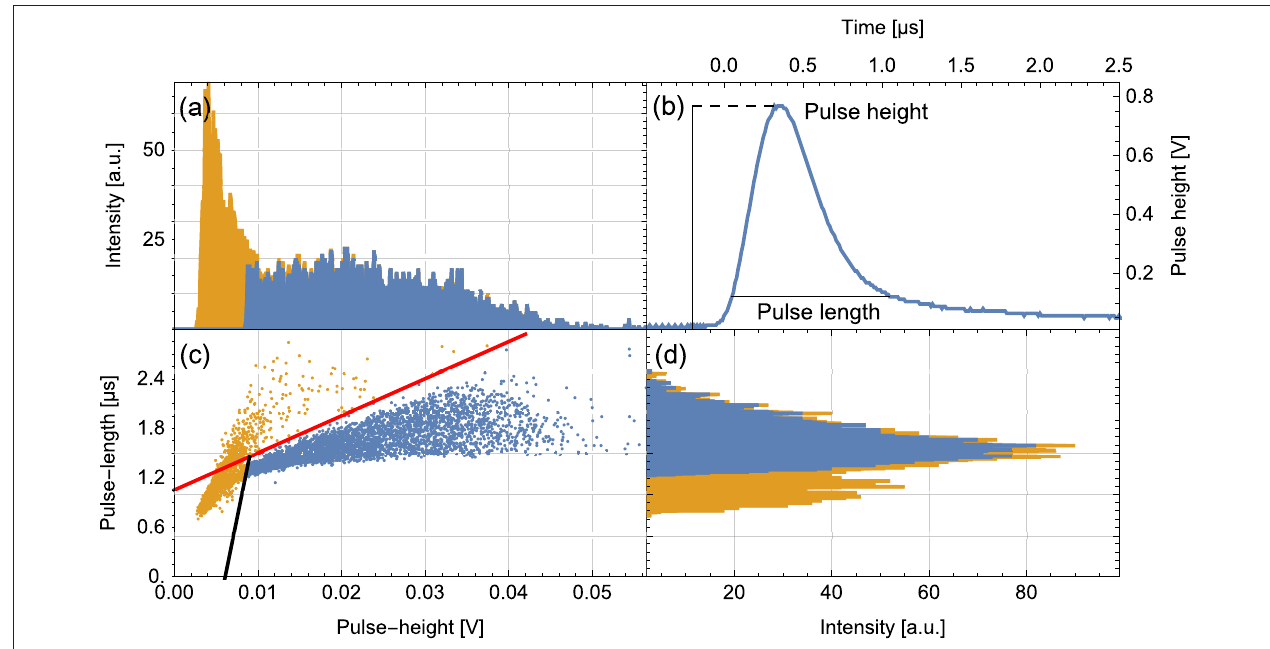
FIGURE 8 | Pulse shape analysis for a boron-lined detector at a counting gas pressure of 1bar. (a) Shows the pulse height spectrum of 6,200 detected events. (b) Displays a pulse generated by the readout electronics corresponding to a neutron event and indicates how pulse height and length are determined. Pulse length corresponds to the time interval during which the pulse exceeds a certain threshold voltage level. The scatter plot (c) depicts the two-dimensional pulse data of the detected events. (d) Shows the event pulse length data as a histogram. (a,d) Are the projections of (c) to the pulse height and length axis, respectively. The blue events could be identified as neutrons whereas the orange cluster contains both electrons and neutrons. These regions can be separated by appropriate thresholds depicted by the red and black line in (c)